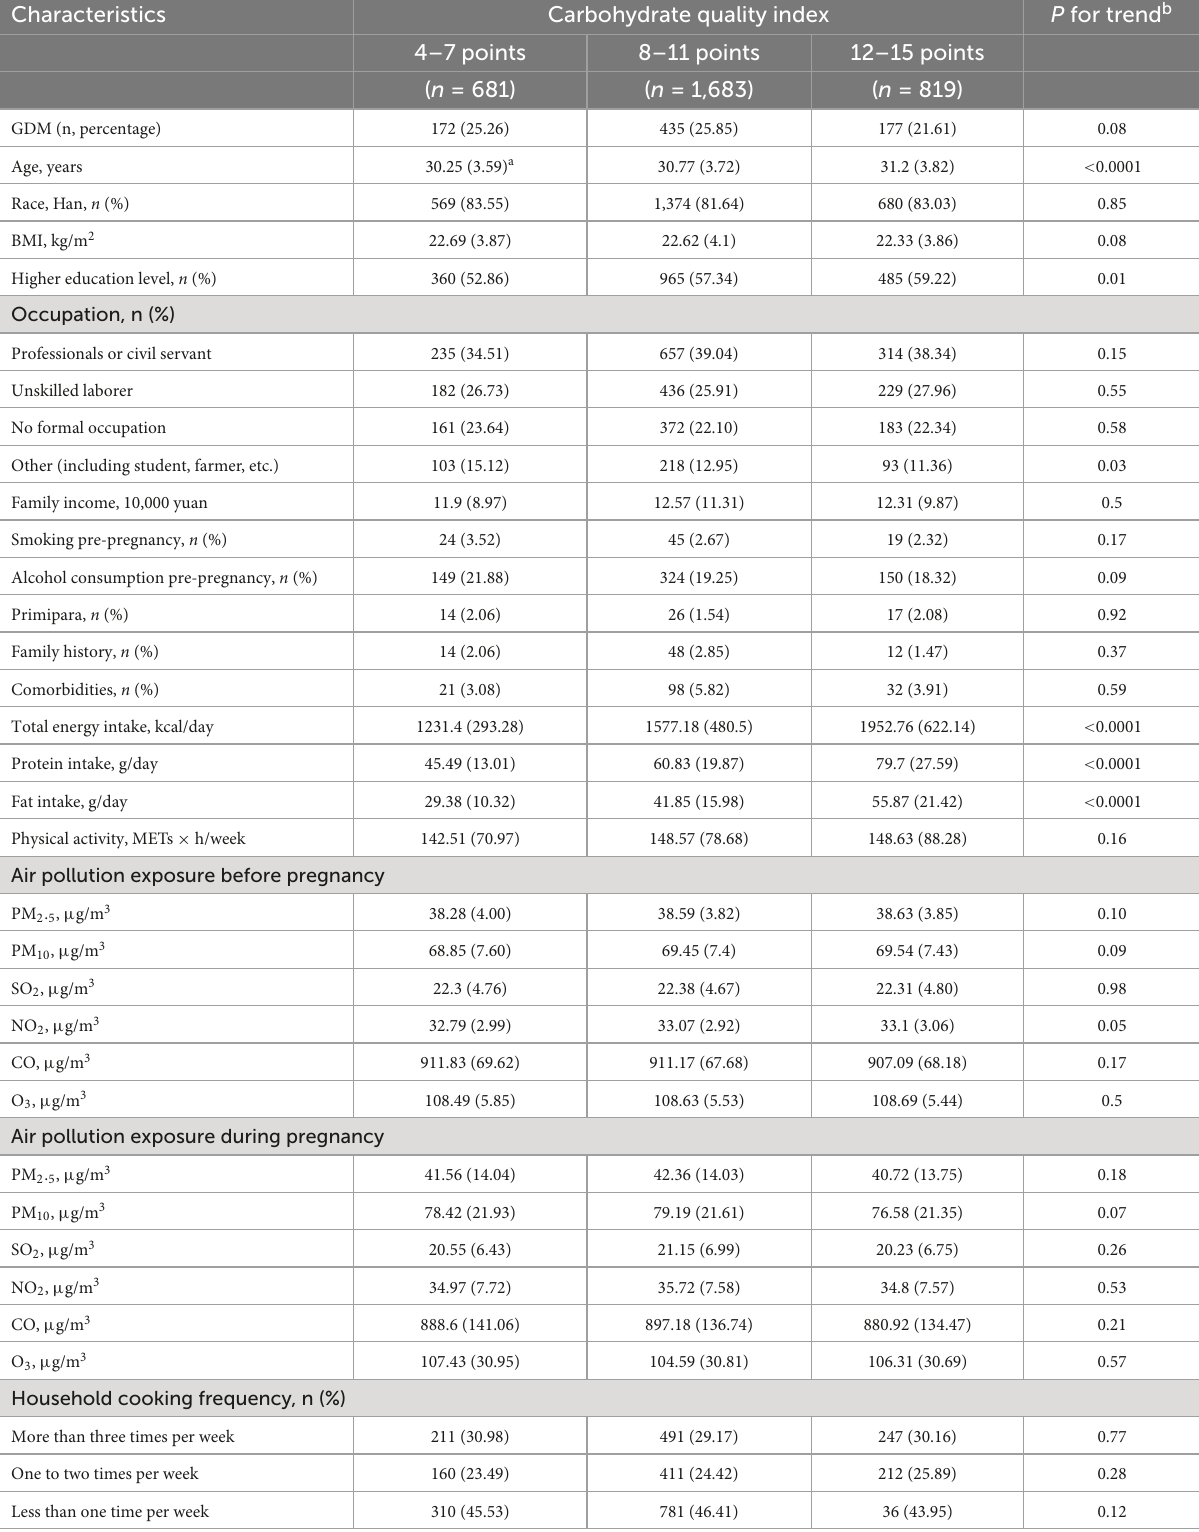
TABLE 2 Characteristics of participants according to CQI